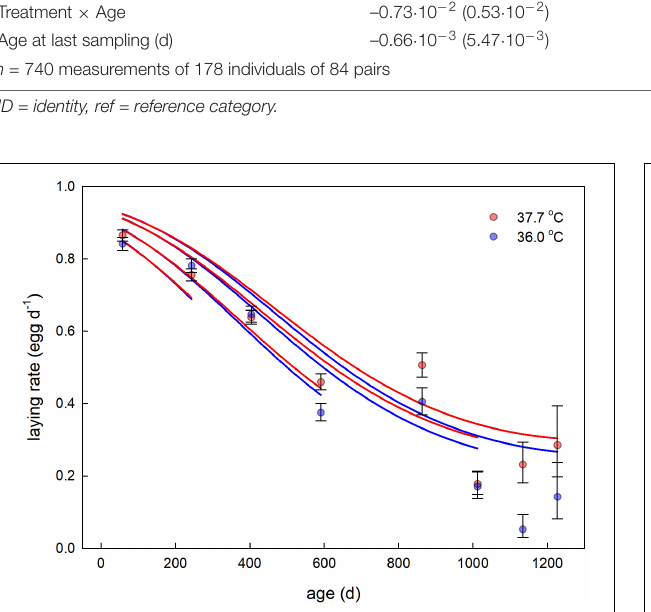
FIGURE 4 | Mass of individual eggs laid plotted against age for female Japanese quail incubated at 37.7 ◦ C ( n = 97 females) or 36.0 ◦ C ( n = 79 females). The lines represent the model prediction (see Table 5 ) for each incubation